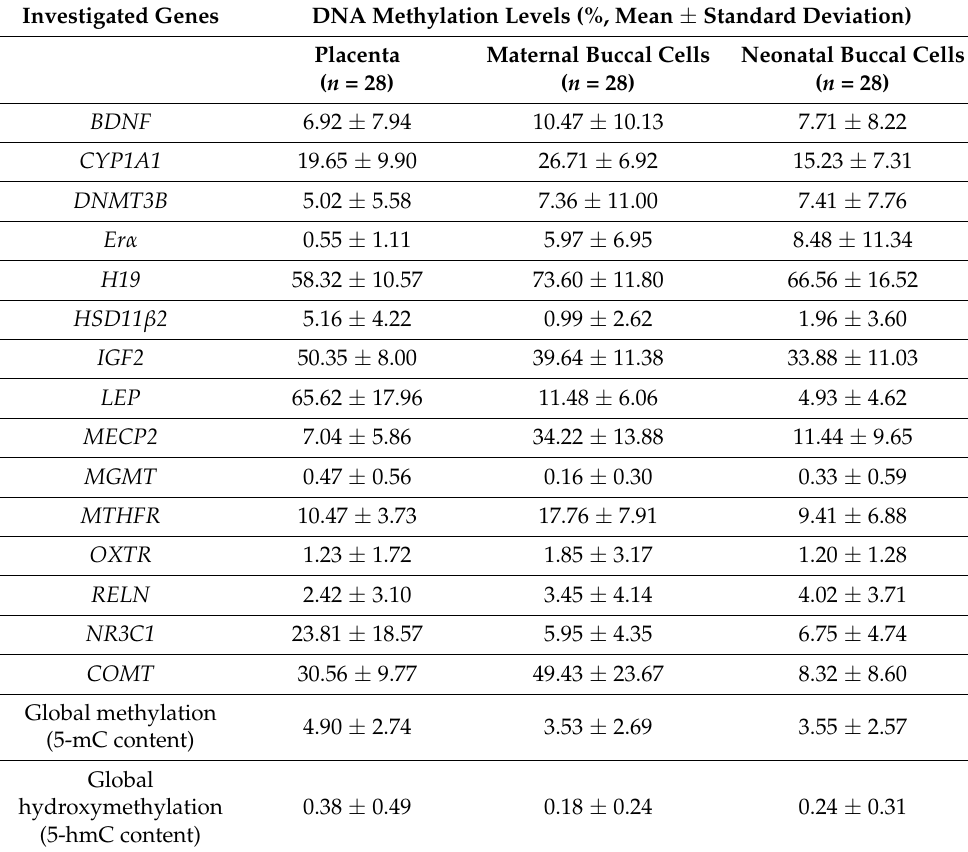
Table 5. Distribution of both gene-specific methylation and global methylation and hydroxymethylation levels in the placenta, neonatal mucosa and maternal mucosa expressed as mean ± standard deviation. Investigated Genes DNA Methylation Levels (%, Mean ± Standard Deviation)